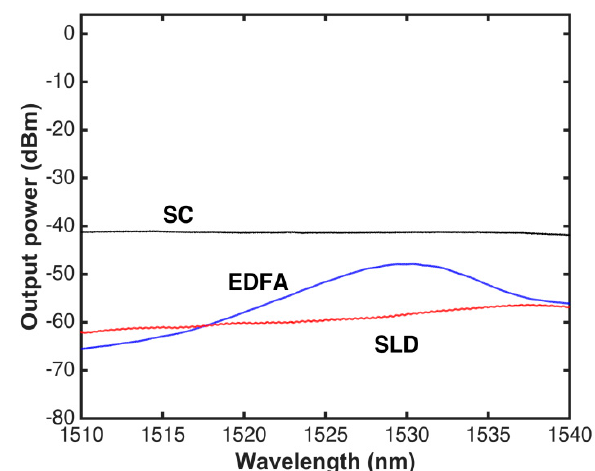
Figure 3. Comparison of supercontinuum (SC), super-luminescent (SLD), and fiber amplification doped with erbium (EDFA).